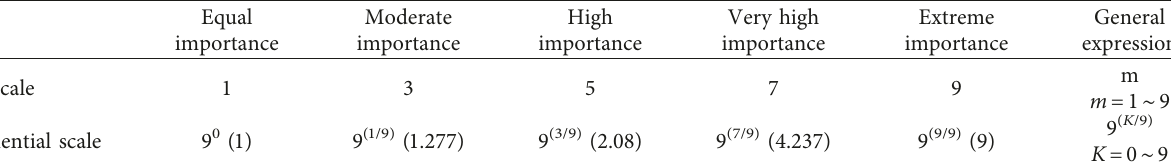
Table 1: Linguistic terms.